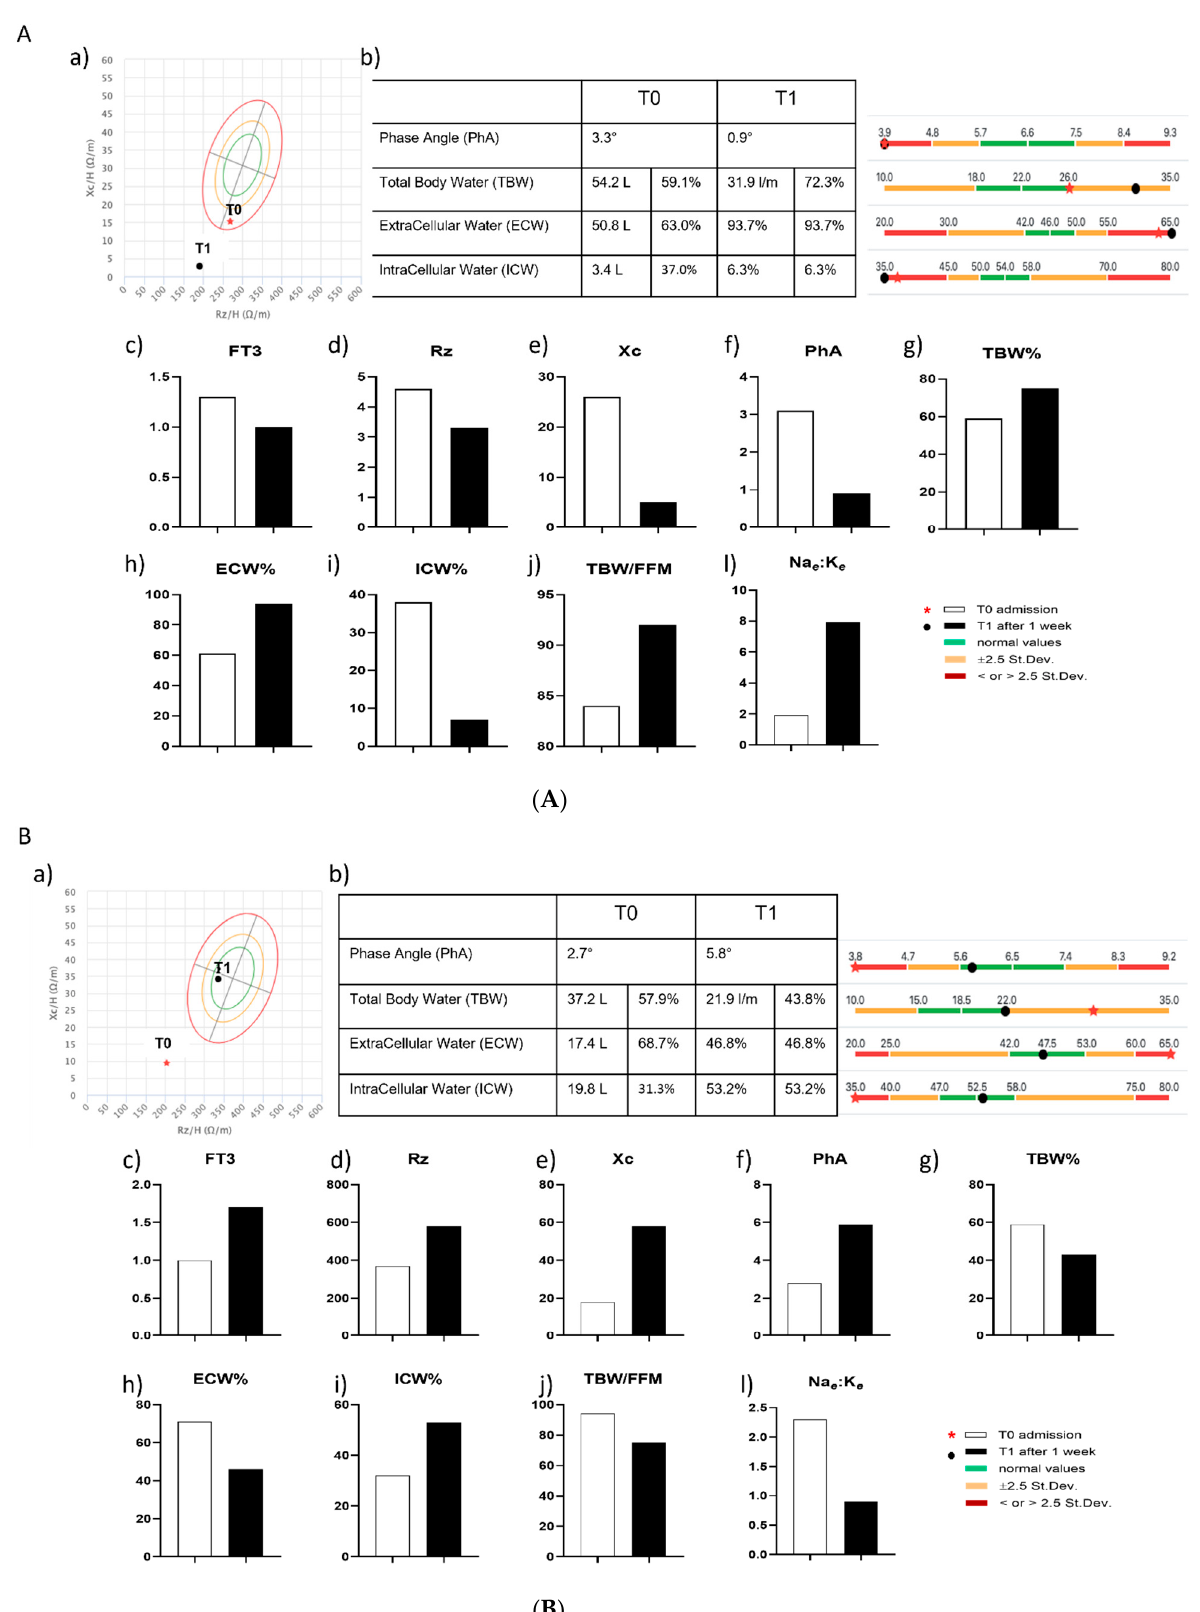
Figure 4. ( A ) BIA measurements in one COVID-19 patient (patient 1) in the pilot study. Measurements performed in a single patient (patient 1), affected by COVID-19, and presenting NTIS at admission, with very low FT3 serum values that were further reduced after one week. ( a ) Rz-Xc (resistance versus reactance) graph, the red star indicates measurement at admission while the black circle indicates measurement after one week; BIA parameters at T0—admission (white bars) and at T1—after one week (black bars); ( b ) graphical representation of the following BIA parameters: PhA, TBW, ECW, and ICW, expressed as % of body weight, measured at T0 and T1; green bars indicate normal reference values, orange bars indicate values included between − and +2.5 standard deviation, red bars indicate values outside– and + 2.5 standard deviation; ( c ) serum FT3 levels in pg/mL, measured at admission (T0) and after one week (T1); changes between T0 and T1 are reported for the following BIA parameters: ( d ) Rz in ohms ( Ω ); ( e ) Xc in ohms ( Ω ); ( f ) PhA in degrees (°); ( g ) TBW %, percentage of total body water; ( h ) ECW %, percentage of extracellular water; ( i ) ICW %, percentage of intracellular water; ( j ) TBW/FFM ratio; ( l ) Na e :K e ratio, sodium/potassium exchangeable ratio. ( B ) BIA measurements in one COVID-19 patient (patient 2) in the pilot study. Measurements performed in a single patient (patient 2), affected by COVID-19, and presenting NTIS at admission, with very low FT3 serum values that were corrected with LT3 administration at 63.9 µg/die for one week. ( a ) Rz-Xc (resistance versus reactance) graph, the red star indicates measurement at admission while the black circle indicates measurement after one week; BIA parameters at T0—admission (white bars) and at T1—after one week (black bars). ( b ) graphical representation of the following BIA parameters: PhA, TBW, ECW, and ICW, expressed as % of bodyweight, measured at T0 and T1; green bars indicate normal reference values, orange bars indicate values included between − and +2.5 standard deviation, red bars indicate values outside– and +2.5 standard deviation; ( c ) serum FT3 levels in pg/mL, measured at admission (T0) and after one week (T1); changes between T0 and T1 are reported for the following BIA parameters: ( d ) Rz in ohms ( Ω ); ( e ) Xc in ohms ( Ω ); ( f ) PhA in degrees (°); ( g ) TBW %, percentage of total body water; ( h ) ECW %, percentage of extracellular water; ( i ) ICW %, percentage of intracellular water; ( j ) TBW/FFM ratio; and ( l ) Na e :K e ratio, sodium/potassium exchangeable ratio. Mitochondrial respiration, measured by Seahorse, indicated a marked dysfunction at T0 in both patients. Both basal and maximal OCR were severely reduced, and ECAR was markedly hampered. We repeated the analysis on PBMCs of patient 1 after in vitro